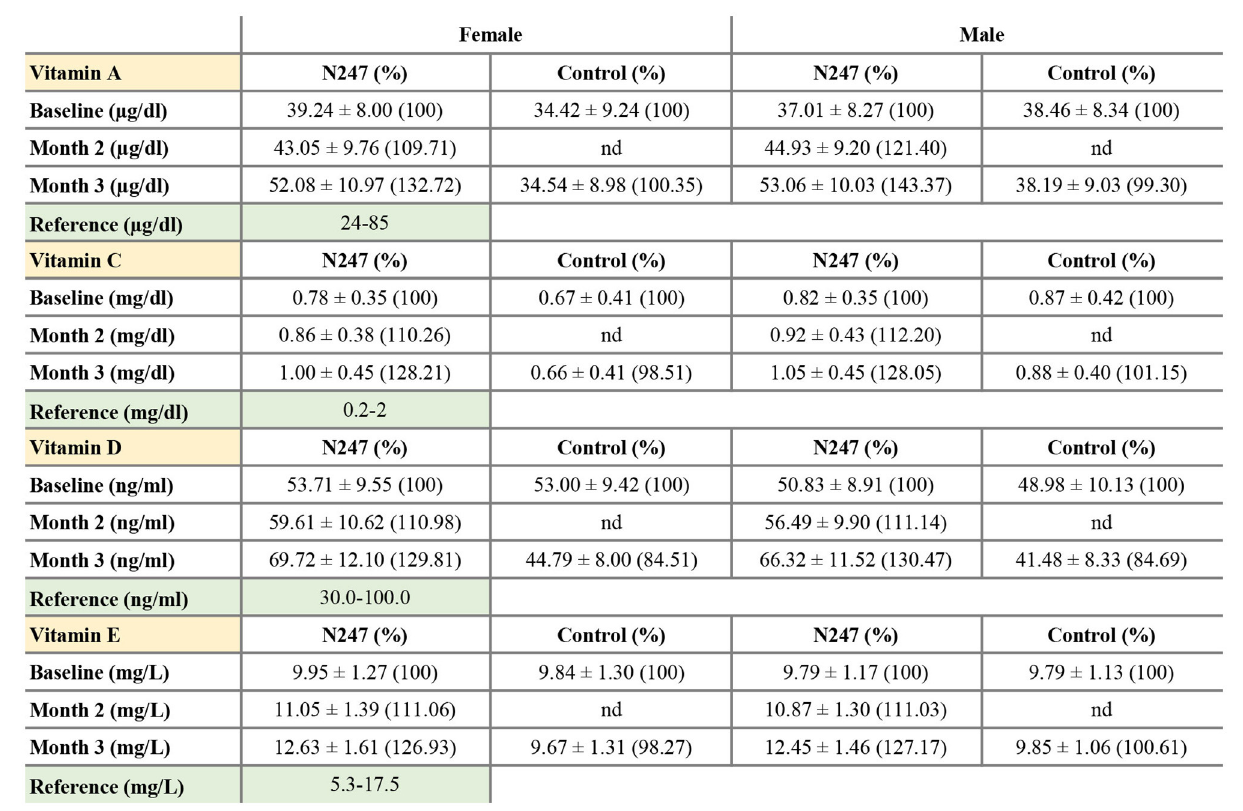
SD. % values are given in ±